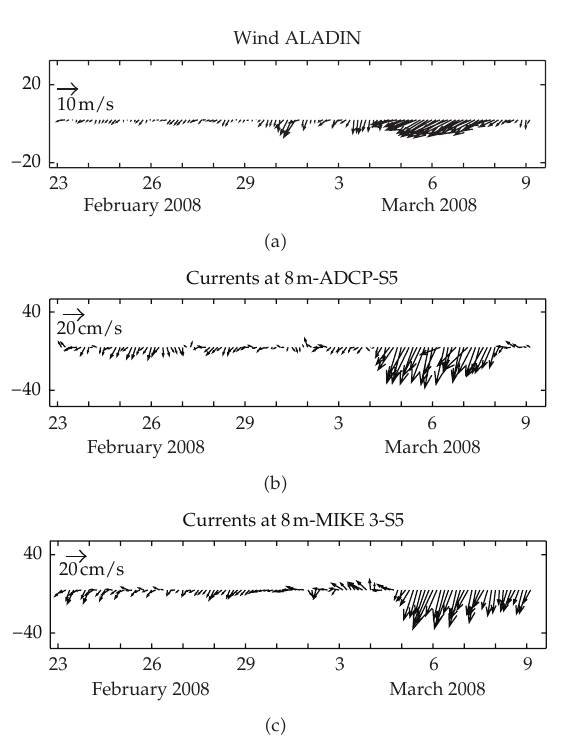
Figure 6: As in Figure 5 but for the ADCP station S5.